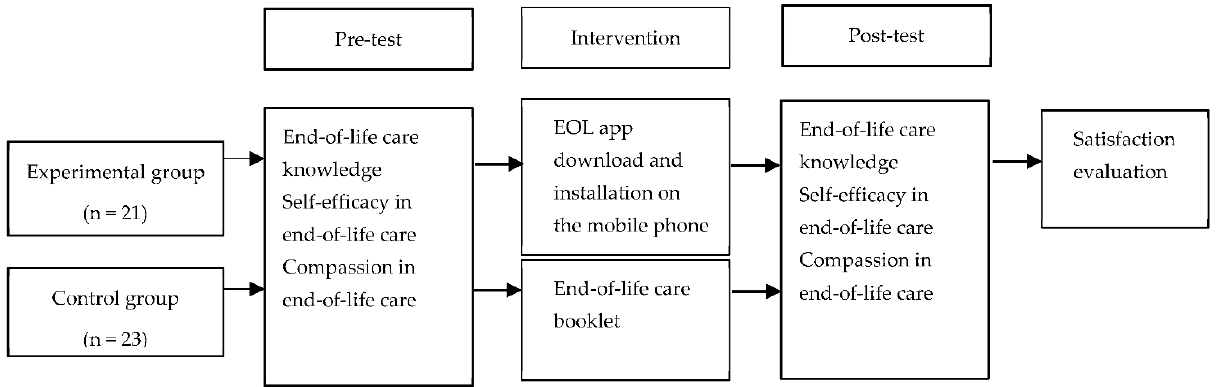
Figure 2. Flow diagram of the study. EOL app; end-of-life care mobile application.